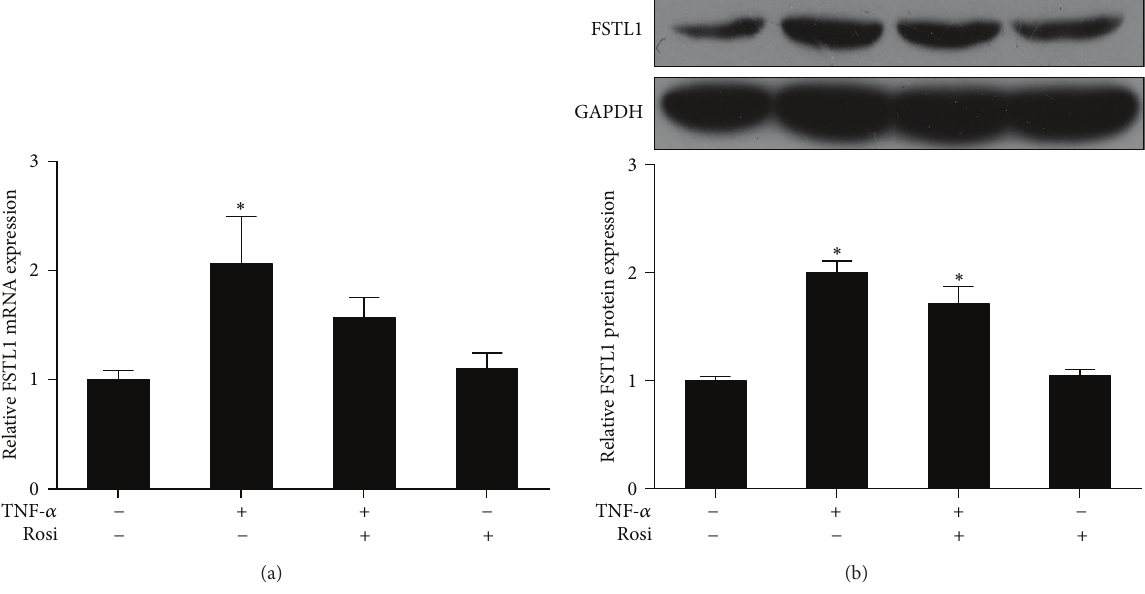
Figure 2: FSTL1 expression is regulated by TNF- 𝛼 in 3T3-L1 adipocytes. Differentiated 3T3-L1 adipocytes were serum-starved for 16 h and then incubated with TNF- 𝛼 (20 ng/mL) for 24h in the presence or absence of rosiglitazone (Rosi; 1 𝜇 M). (a) Fstl1 mRNA expression was evaluated by quantitative RT-PCR and normalized to 𝛽 -actin. Data are expressed as fold of control. (b) FSTL1 protein expression was assessed by Western blot analysis (top) and quantified by densitometry (bottom). Data were normalized to GAPDH and expressed as fold of control. Data are mean ± SE; 𝑛 = 3 . ∗ 𝑃 < 0.05 versus